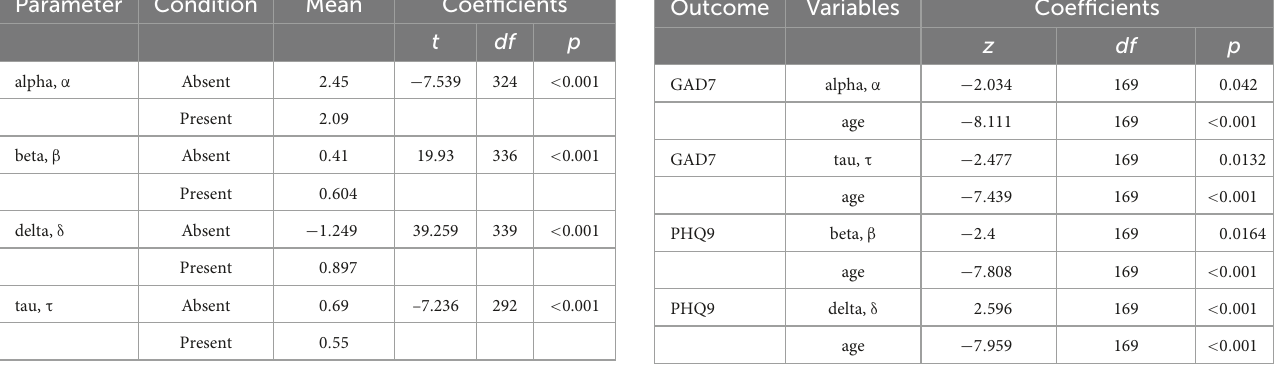
TABLE 6 GLMs for the association between cognitive parameters and symptom scores. Outcome